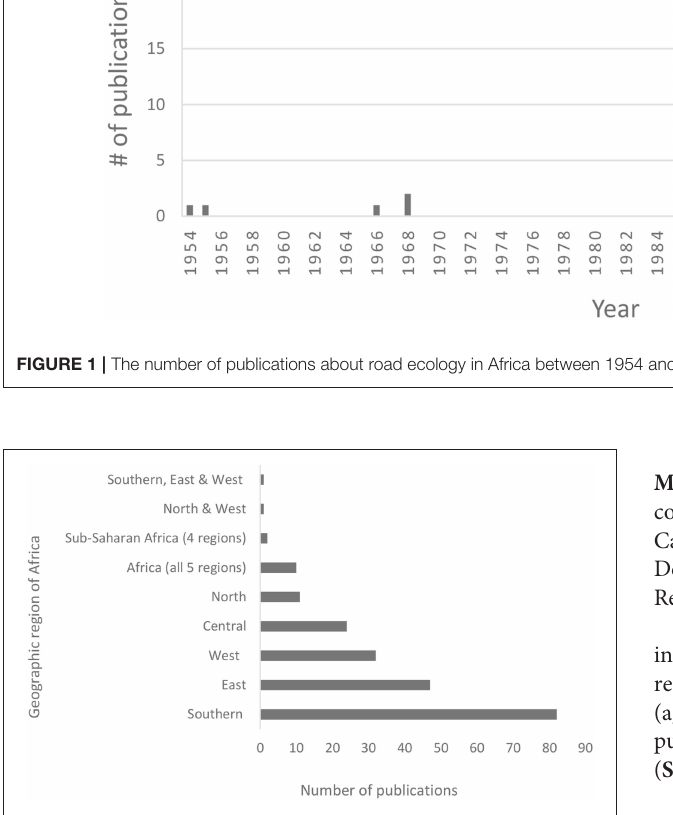
FIGURE 2 | The number of road ecology publications by African region between 1954 and 2016.